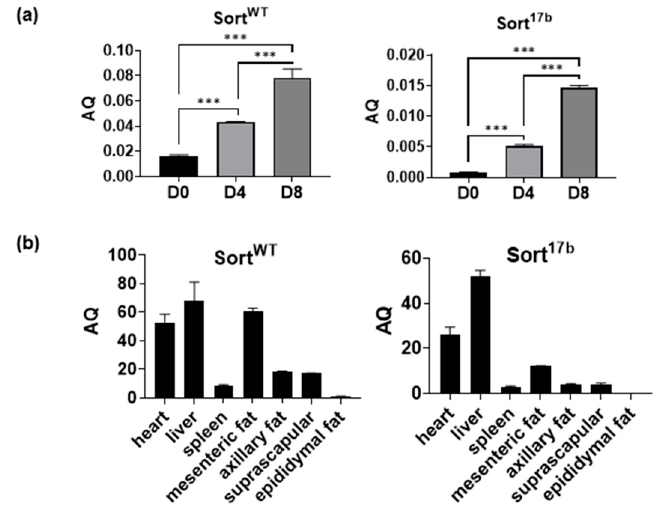
Figure 2. Endogenous expression levels of murine sortilin variants. ( a ) Total RNA was isolated from differentiating 3T3L1 cells harvested at days 0, 4, and 8. Real-time SYBR Green qPCR was performed using primers specifically targeting the 17/18 exon junction (to detect Sort WT ) or within exon 17b (to detect Sort 17b ). A standard curve for each sortilin variant was included with the qPCR assay along with samples run in triplicate. Absolute quantification (AQ, ng) for Sort WT and Sort17b was calculated by normalizing the values to β -actin ( n = 5). Statistical analysis was performed by one-way ANOVA; *** p < 0.001 between day 0, 4 and 8 samples for Sort WT and Sort 17b variants. ( b ) Organs and specific adipose depots were harvested from C57BL6 mice and homogenized in a bead homogenizer. RNA was isolated and real-time SYBR Green qPCR was performed using primers specifically targeting the 17/18 exon junction (to detect Sort WT ) or within exon 17b (to detect Sort 17b ). Absolute quantification (AQ, ng) for Sort WT and Sort17b was calculated by normalizing the values to β -actin ( n = 4).